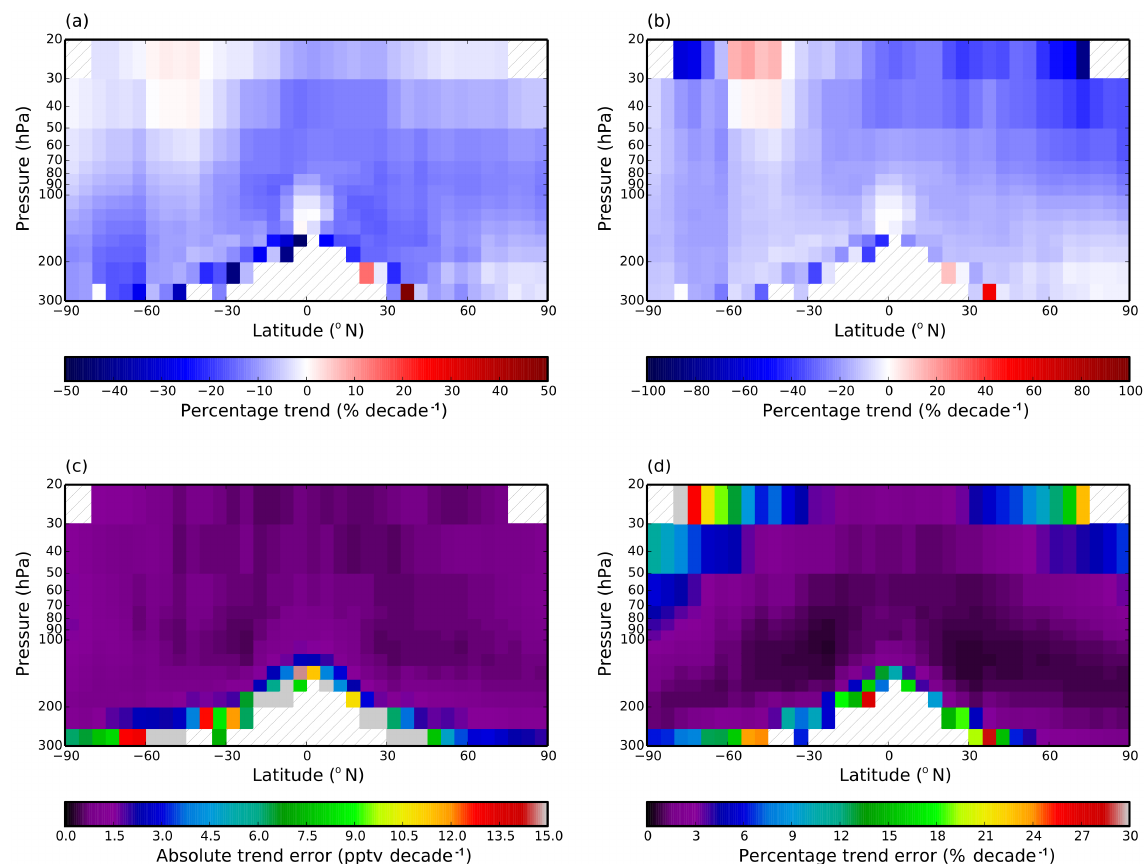
Figure 11. CCl 4 trends as a function of latitude and pressure. Panel (a) shows absolute trends, (b) percentage trends, (c) absolute errors, and (d) percentage errors. Latitudes and pressures with a trend error greater than 30% are masked with dashed areas.